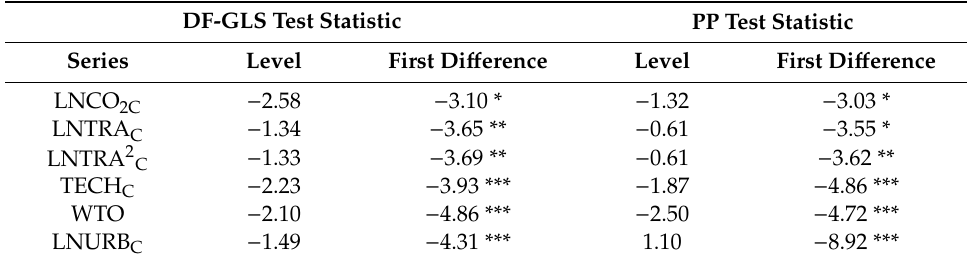
Table 7. Unit root tests results for Model 1—Bilateral trade from China to Germany.